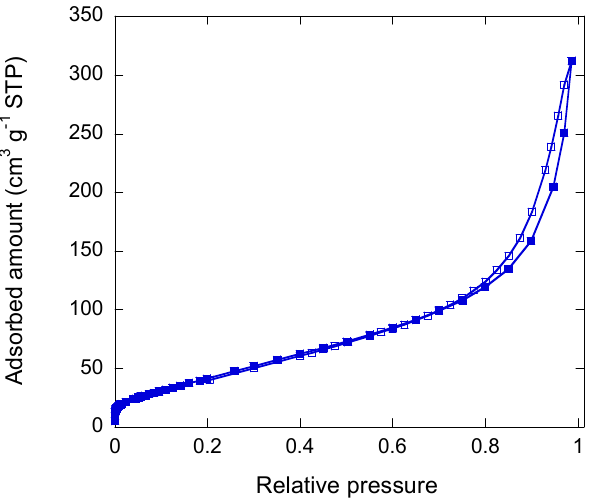
Figure 8. N 2 adsorption–desorption isotherm at − 196 °C of the nickel nano-oxide. Full and open symbols correspond to adsorption and desorption, respectively.